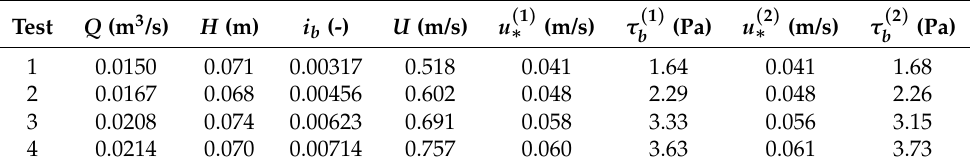
Figure 2. ( a ) Scheme of the complete flume setup; ( b ) general view of the flow over the mobile-bed reach; ( c ) granular bed, prior to water working, showing the simple lattice arrangement. Table 1. Characterization of the mean